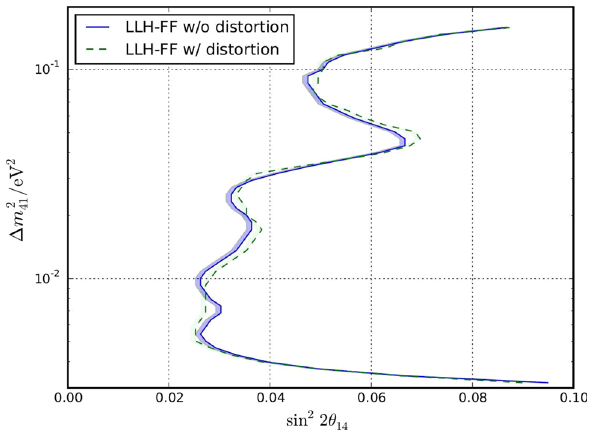
Fig. 8 Sensitivity (95% C.L.) of the analysis as obtained from Asimov data sets with and without a spectral distortion at 5 MeV